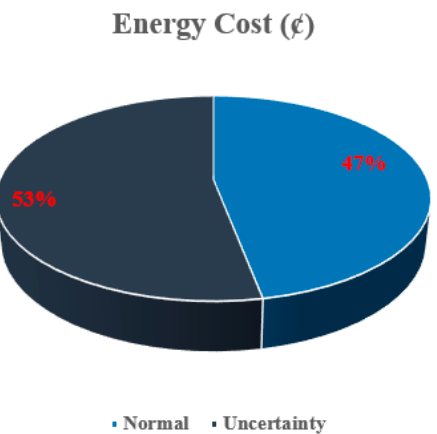
Figure 14. The energy cost for the normal and uncertain manners.